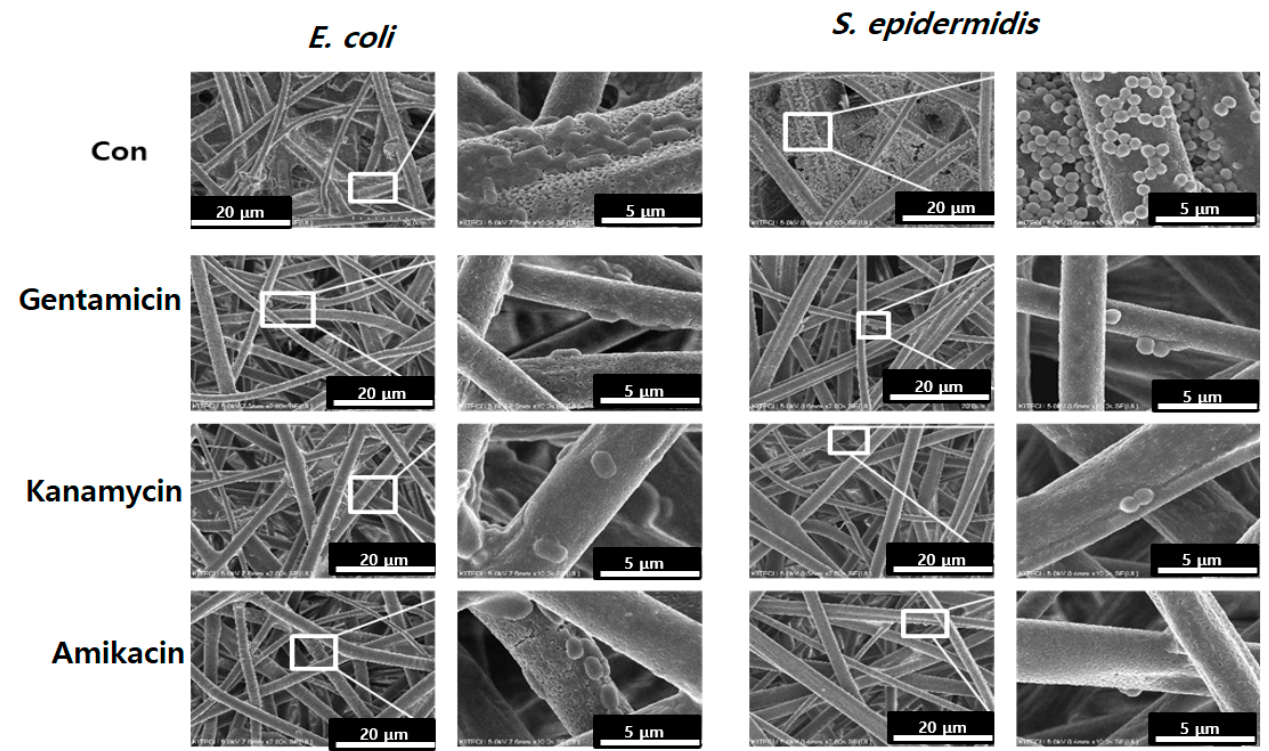
Figure 6. Bacterial adhesion on the AD-loaded 7:3 PLA fibers.